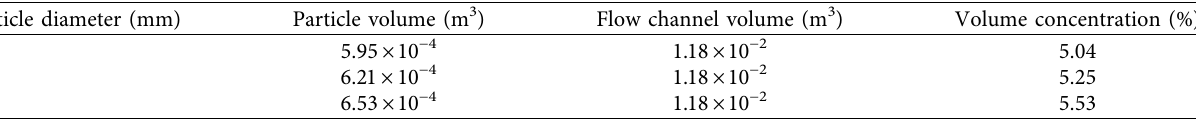
Figure 5: Particle volume concentration pulsation curve of various Table 2: Particle volume concentration at a stable moment.